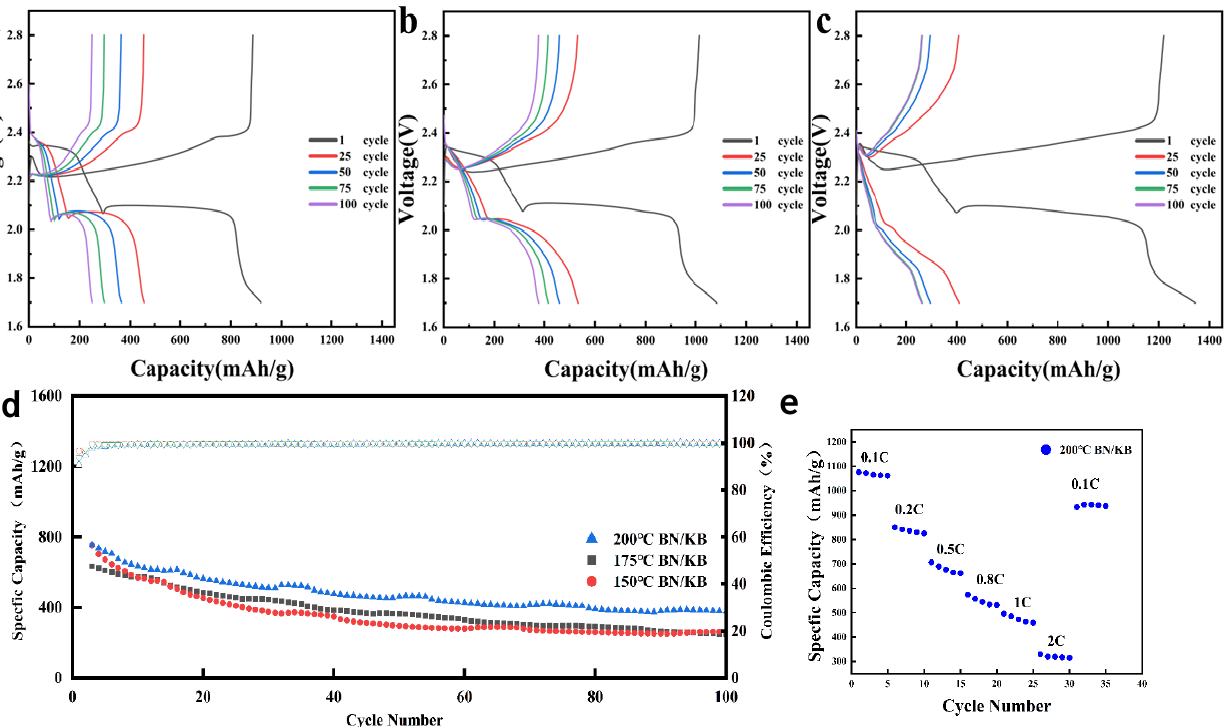
Figure 7. Charge/discharge plateau curves ( a – c ) and specific capacity cycling curves ( d ) for BN/KB at 200 °C, 175 °C and 150 °C, rate performance ( e ).